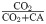
Effects of 12 weeks of exercise on myotube fatty acid metabolism.Satellite cells isolated from biopsies from m. vastus lateralis before and after 12 weeks of exercise were cultured and differentiated to myotubes. Oxidation, cell-associated (CA) radioactivity and lipid accumulation of [14C]oleic acid were measured, and total cellular uptake (CO2+CA), oxidation (CO2), fractional oxidation (CO2CO2+CA), and lipid accumulation were determined. (A) Lipid accumulation presented as cpm/μg protein. Values are presented as means ± SEM for all participants combined (n = 18). (B) Oleic acid oxidation and total cellular uptake presented as nmol/mg protein. Values are presented as means ± SEM for all participants combined (n = 18). (C) Fractional oleic acid oxidation. Values are presented as means ± SEM for all participants combined (n = 18). (D) Fatty acid metabolism relative to before exercise. Values are presented as means ± SEM for all participants combined (n = 18). (E) Lipid accumulation presented as cpm/μg protein in study group when separated by BMI. Values are presented as means ± SEM (n = 7 in the normal weight group and n = 11 in the overweight group). (F) Oleic acid oxidation and total cellular uptake presented as nmol/mg protein in study group when separated by BMI. Values are presented as means ± SEM (n = 7 in the normal weight group and n = 11 in the overweight group). (G) Fractional oleic acid oxidation in absolute values in study group when separated by BMI. Values are presented as means ± SEM (n = 7 in the normal weight group and n = 11 in the overweight group). (H) Fatty acid metabolism relative to before exercise in study group separated by BMI. Values are presented as means ± SEM (n = 7 in the normal weight group and n = 11 in the overweight group). *Statistically significant vs. before exercise (p < 0.05, linear mixed-model analysis, SPSS). #Statistically significant vs. normal weight group after exercise (p < 0.05, linear mixed-model analysis, SPSS). $Statistically significant vs. normal weight group (p < 0.05, linear mixed-model analysis, SPSS).